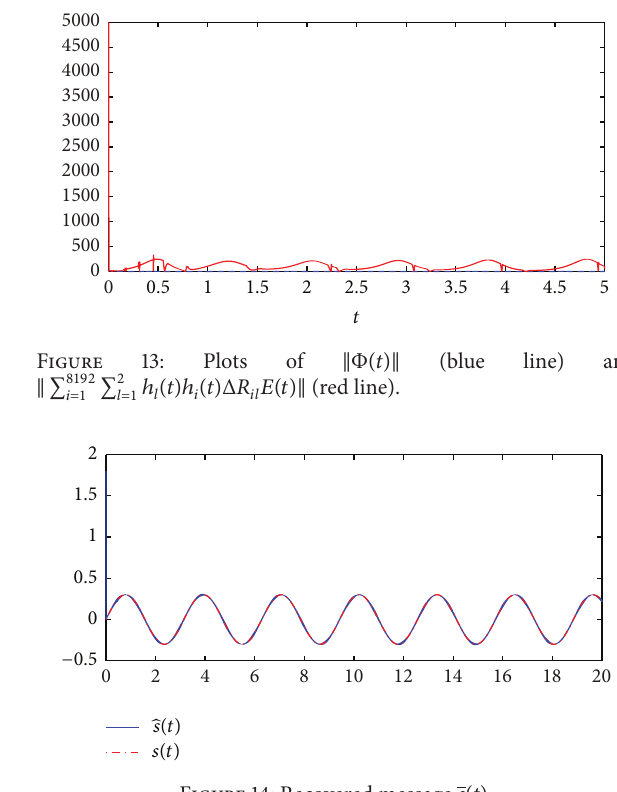
Figure 14: Recovered message 𝑠(𝑡)